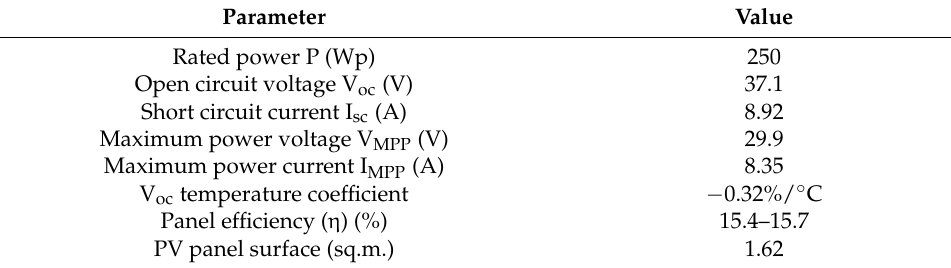
Table A3. Electrical characteristics and surface of PV panels.